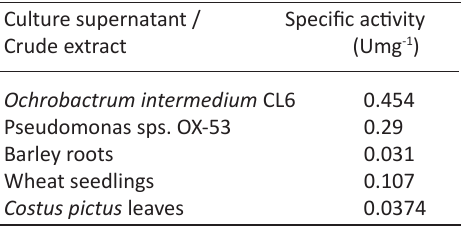
Table 1. Comparison of oxalate oxidase activity from Ochrobactrum intermedium CL6 and other